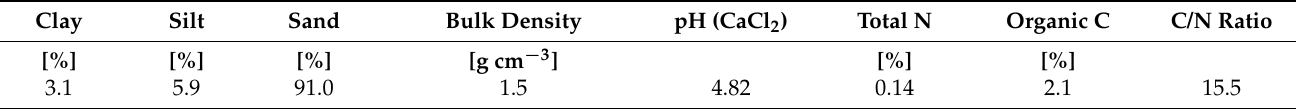
Table 1. Physical and chemical data of surface soil from Fuhrberg, Germany (sand, 5 to 20 cm depth). Clay